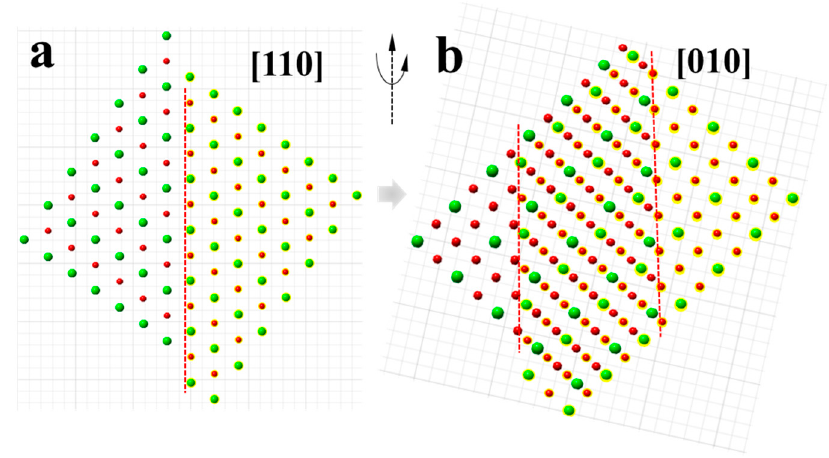
Figure 6. Atomic illustration of the defects viewed along ( a ) the [110] and ( b ) [010]